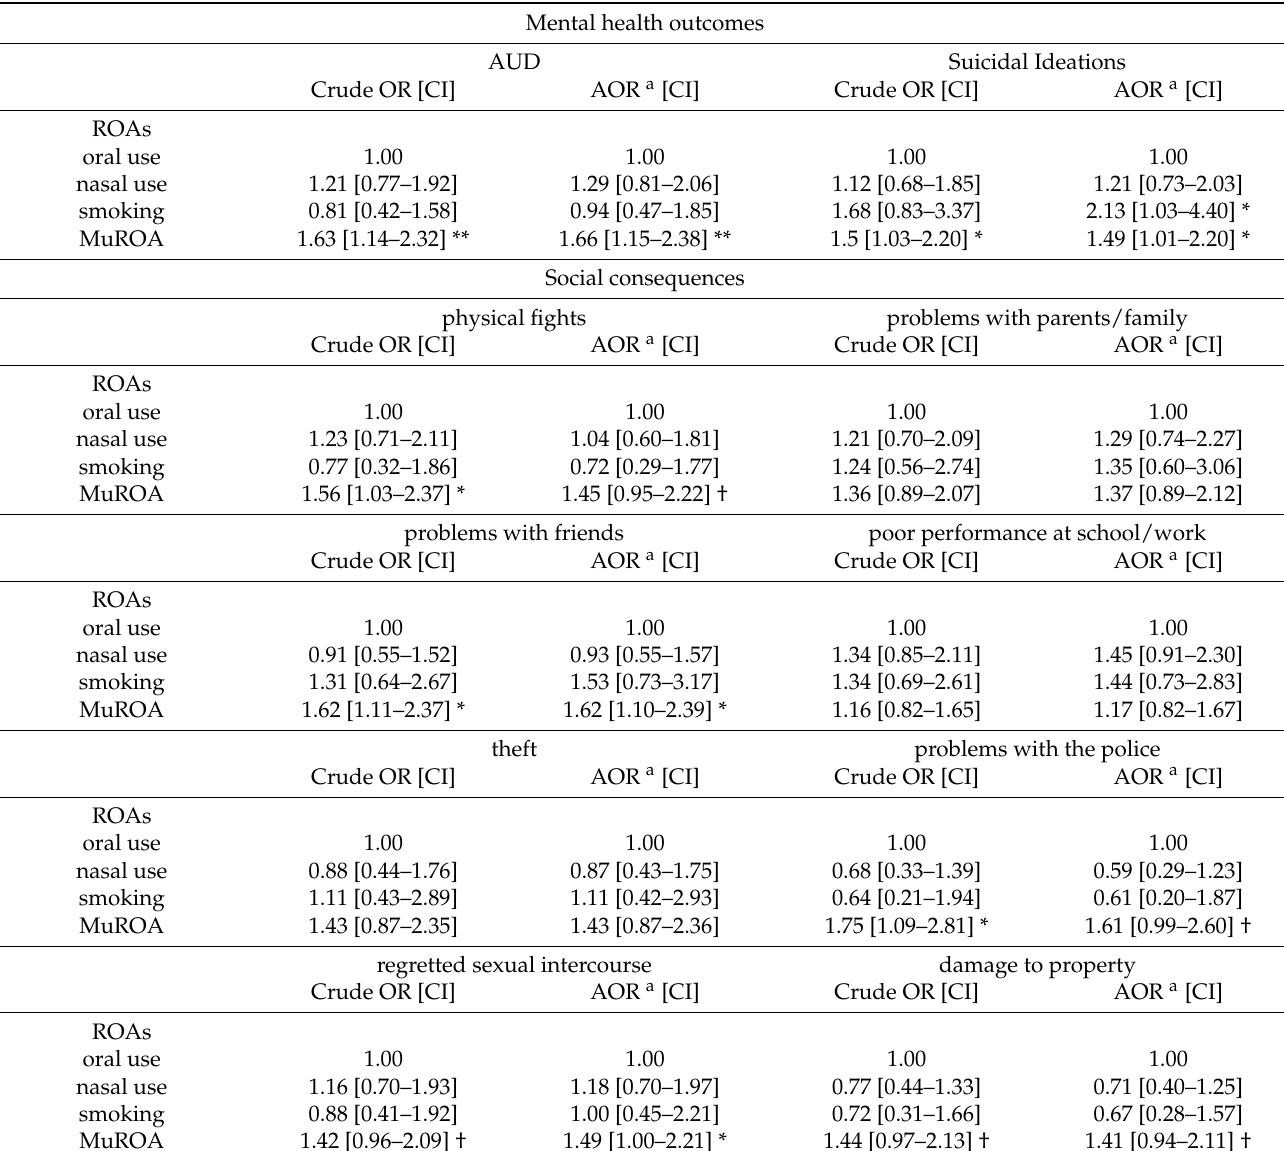
Table 6. Logistic regression analyses with mental health outcomes and social and health consequences as outcomes. The analyses were performed for users of any of the 18 illicit drugs. Mental health outcomes AUD Suicidal Ideations Crude OR [CI] AOR a [CI] Crude OR [CI] AOR a